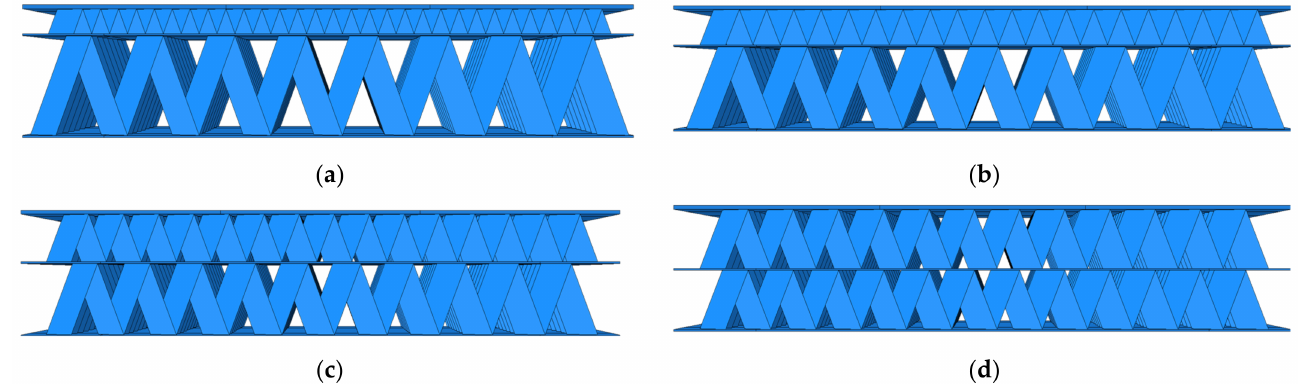
Figure 11. Double-layer structure with different height combinations. ( a ) h 1 = 5 mm, h 2 = 20 mm; ( b ) h 1 = 7.5 mm, h 2 = 17.5 mm; ( c ) h 1 = 10 mm, h 2 = 15 mm; ( d ) h 1 = h 2 = 12.5 mm. Low-velocity impact simulations with impact energies of 5 J, 10 J, 20 J, 30 J, and 40 J were performed on these three double-layer structures. The impactor displacement-time curves are shown in Figure 12, and the residual kinetic energy of the impactor is shown in Figure 13.